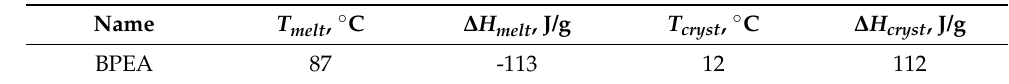
Figure 3. DSC thermogram of the BPEA. Table 4. DSC results of adipate